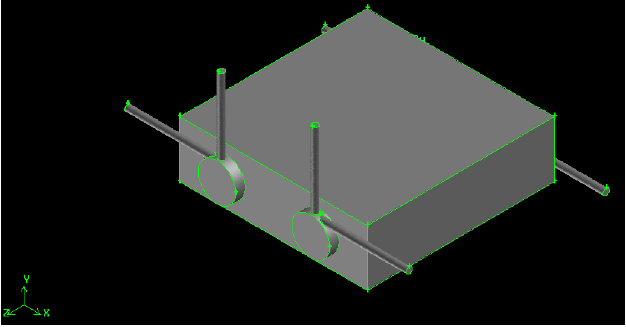
Figure 2. Swirling combustor converter, Z / D = 5.